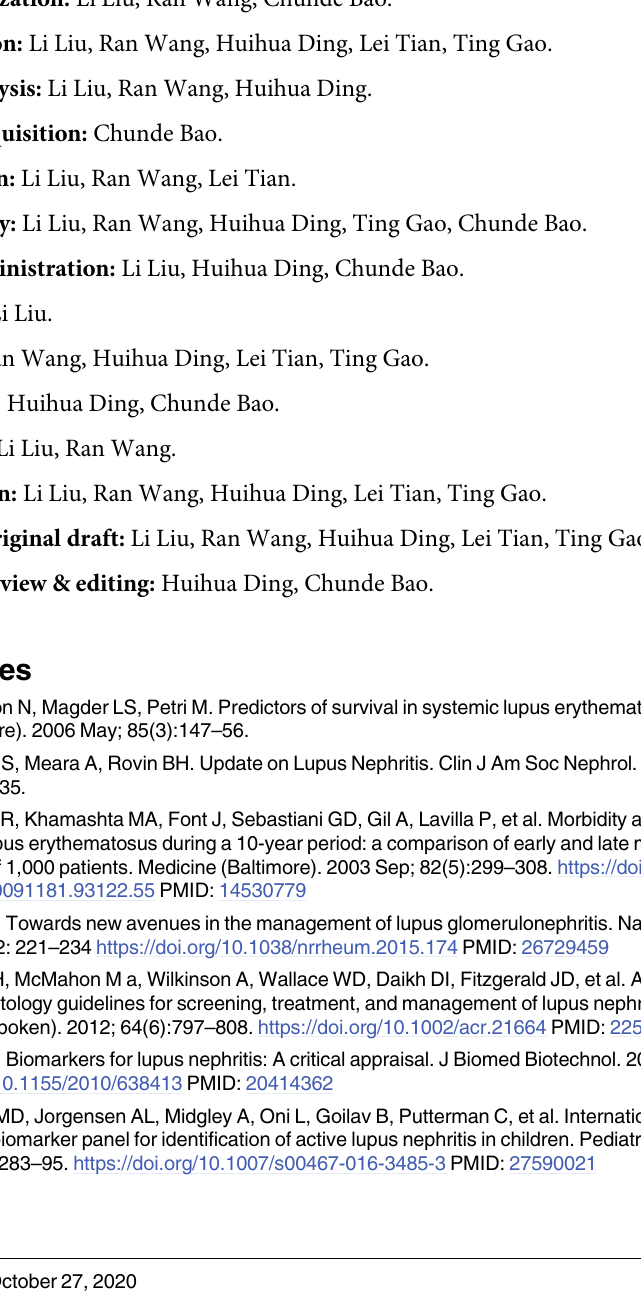
S1 Fig. Study flow diagram. S1 Table. Baseline characteristics of patients with different renal